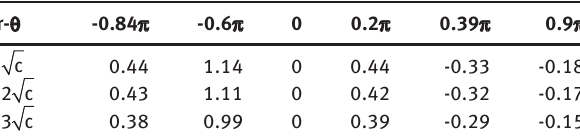
Table 2 Numerical estimate of gradient elasticity shear stress σ